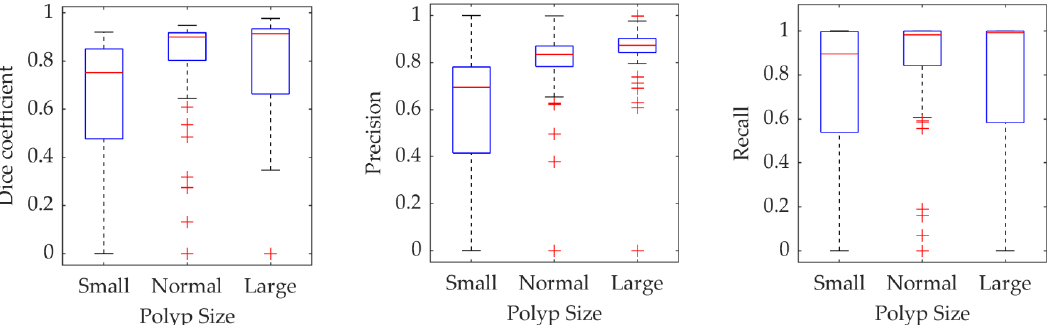
Figure 11. Statistics for different measures on the validation results obtained for the Dilated ResFCN network grouped as a function of the poly size.